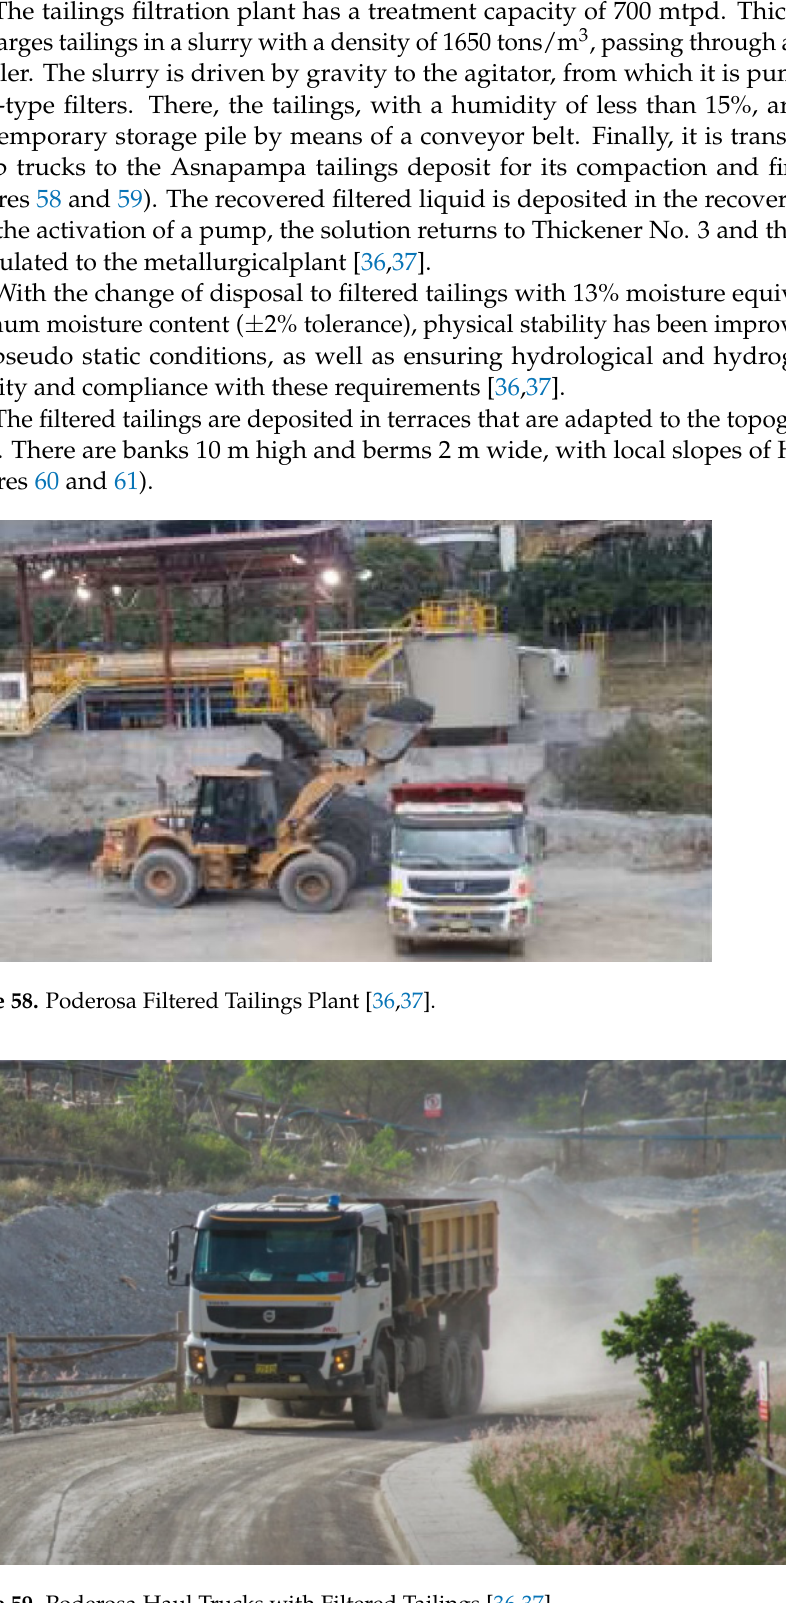
Figure 59. Poderosa Haul Trucks with Filtered Tailings [36,37].